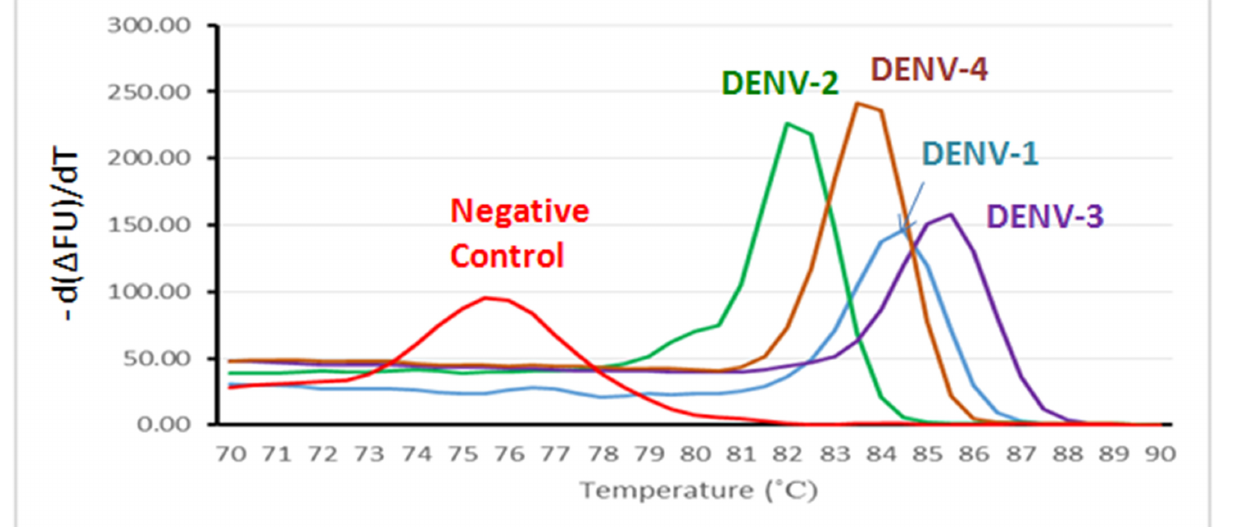
Fig 3. Melting curves for dengue virus (DENV) genotypes 1 through 4 using real-time PCR with SYBR Green I. The peaks of melting curves were clearly separated. T m values for DENV-1, DENV-2, DENV-3, and DENV-4 were 84, 81.5, 85, and 83°C,